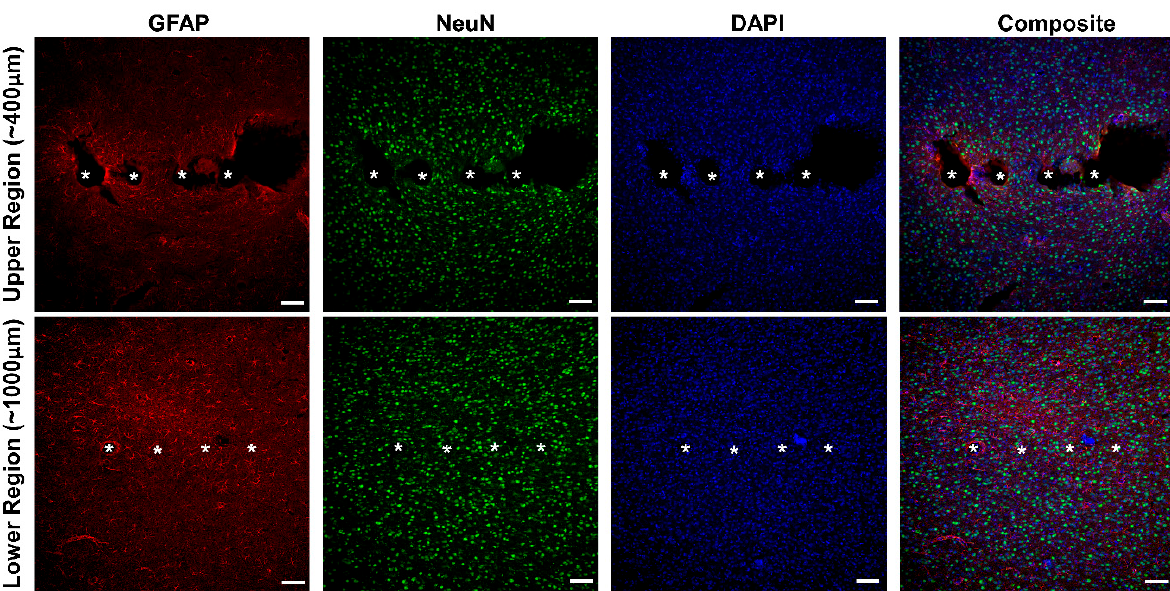
Figure 6. Immunohistological profile of cortical tissue implanted with multi-shank arrays at two depths. The columns indicate activated astrocytes/macrophages (GFAP), neuronal nuclei (NeuN), cell bodies (DAPI) and Composite images. Rows represent tissue collected at superficial (top panel, ~400 μ m) and deeper (bottom panel, ~1000 μ m) depths. The white asterisks (*) on the individual images in the panel indicate the presumptive sites of the device shanks. Scale bar = 100 μ m.